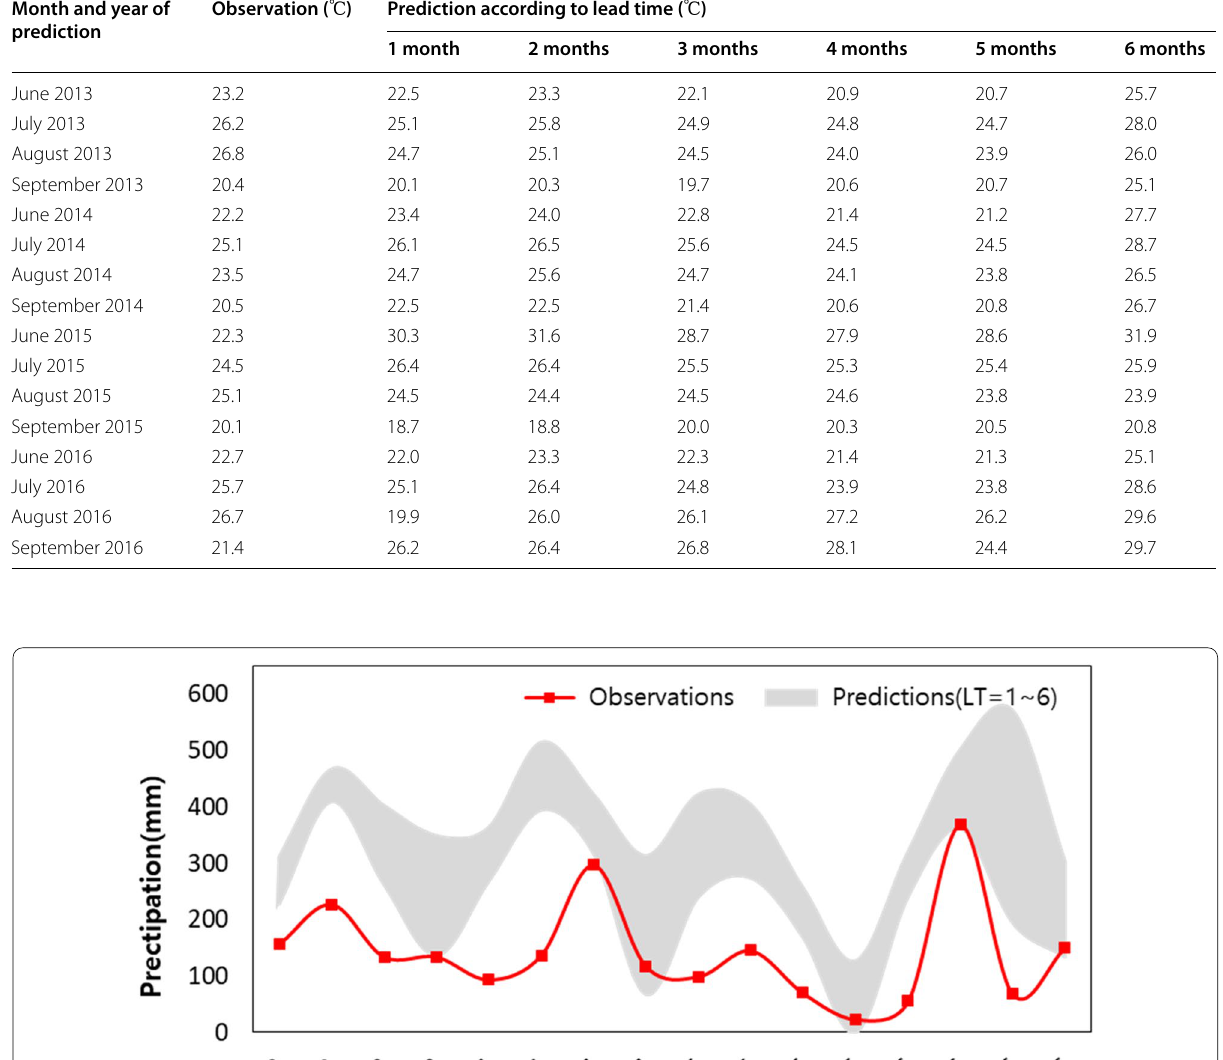
monthly precipitation, the general method overesti- mated the values during 2015, which was likely caused by the effects of El Niño on precipitation. As a result of the application of the modified method, which con- sidered the effects of El Niño, the prediction errors of the 2015 results were reduced. The results in Table 13 suggest that the modified method achieved outstand- ing results, except for the NRMSE results with lead times of 5 and 6 months. However, the NRMSE results